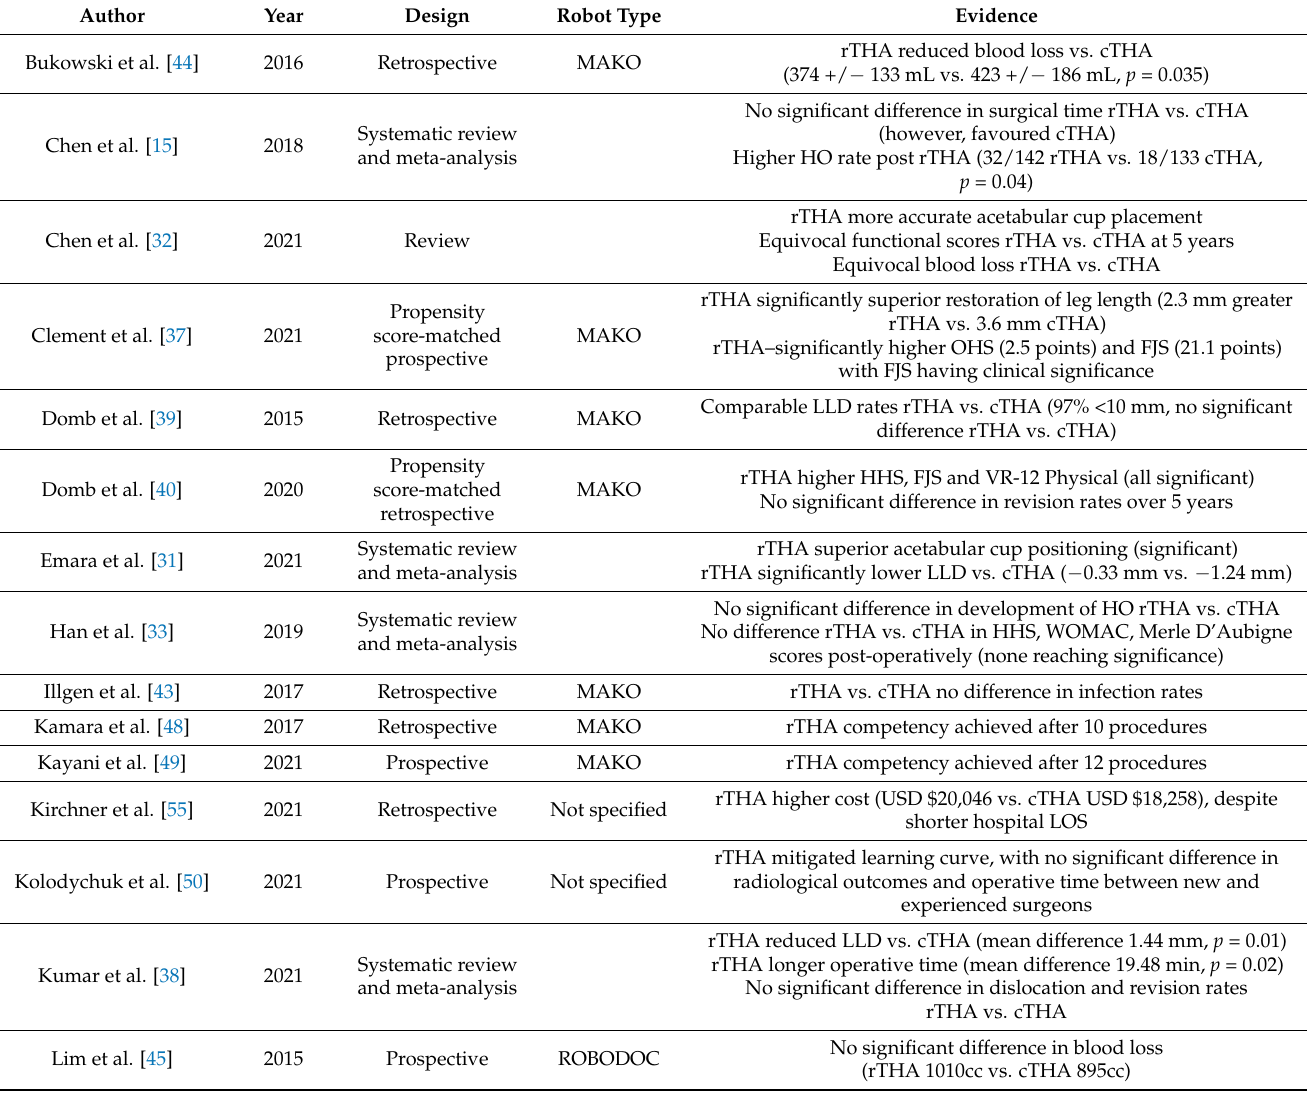
Table 1. Summary of papers reviewed in this